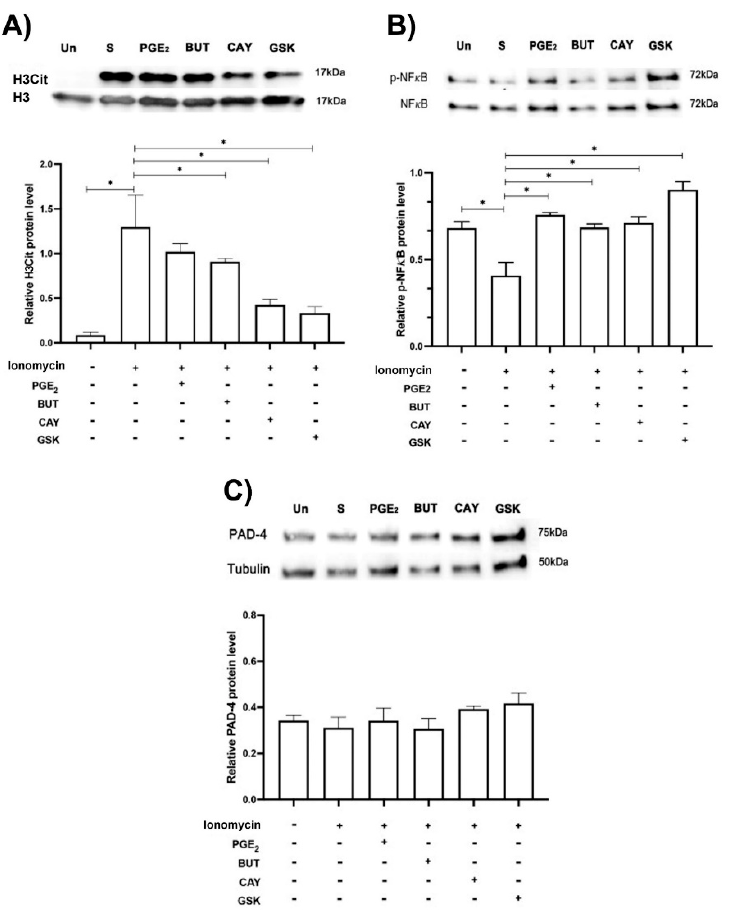
Figure 5. EP2 and EP4 agonists affected H3 citrullination and NF κ B phosphorylation in ionomycin-treated neutrophils. Blotting of H3 Cit, PAD-4, and NF κ B phosphorylated (p-NF κ B) of neutrophils in normal condition (unstimulated condition, Un) and treated with ionomycin (1.25 µ M, S) and plus PGE 2 (10 nM), EP2 (10 nM, BUT, butaprost) and EP4 (10 nM, CAY, CAY-10598) PGE2 agonists, and the PAD-4 selective inhibitor GSK (10 µ M, GSK-484). Representative image of blotting and density analysis of H3 Cit ( A ), NF κ B phosphorylated ( B ), and PAD-4 ( C ). H3Cit was augmented in the presence of ionomycin (S, stimulated) in comparison with the unstimulated condition (Un), while BUT and CAY (PGE 2 agonists), and GSK (PAD-4 selective inhibitor) significantly reduced H3Cit. NF κ B phosphorylation was significantly reduced with ionomycin, while PGE 2 , BUT CAY, and GSK prevented ionomycin-NF κ B phosphorylation inhibition in neutrophils. PAD-4 protein expression was not modified under any of the aforementioned conditions. Representative blots from 5 independent experiments. Bars represent the mean ± SE (lower panels). * p <